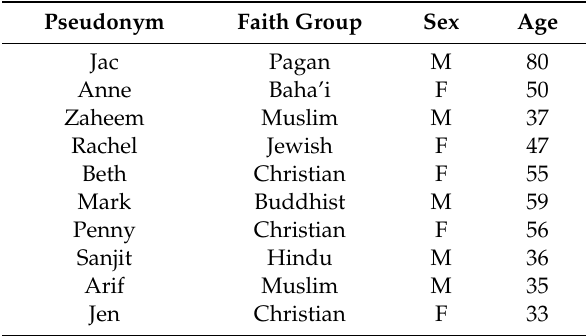
Table 1. A summary of participants’